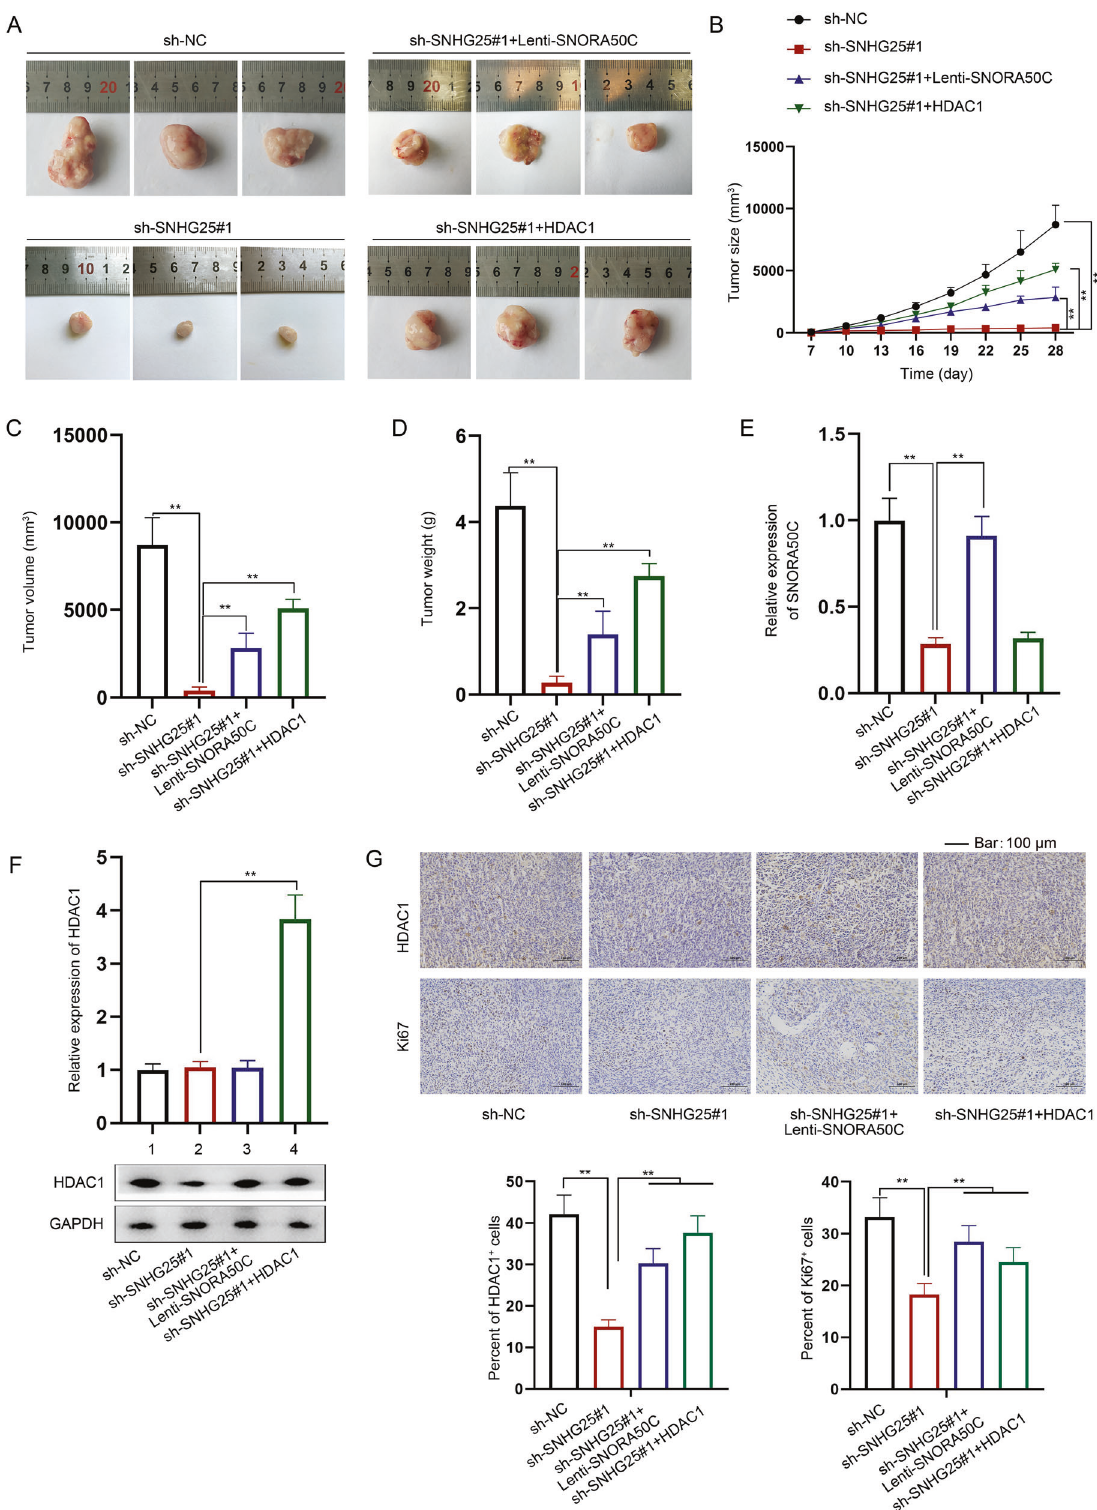
Fig. 7 SNHG25 promotes NB tumor growth in vivo through SNORA50C/HDAC1 axis. Mice were injected with cells transfected with sh-NC, sh-SNHG25#1, or sh-SNHG25#1 + HDAC1, respectively. A – D Representative images of xenografts, tumor size, volume, and weight were shown. (One-way ANOVA, Tukey) E , F RT-qPCR and western blot detected SNORA50C and HDAC1 expression in the xenografts. (One-way ANOVA, Tukey) G The protein expression of HDAC1 and Ki67 was detected by IHC, with the quantitative histograms aside. ** P < 0.01. Error bars indicate mean ± SD. ( N =